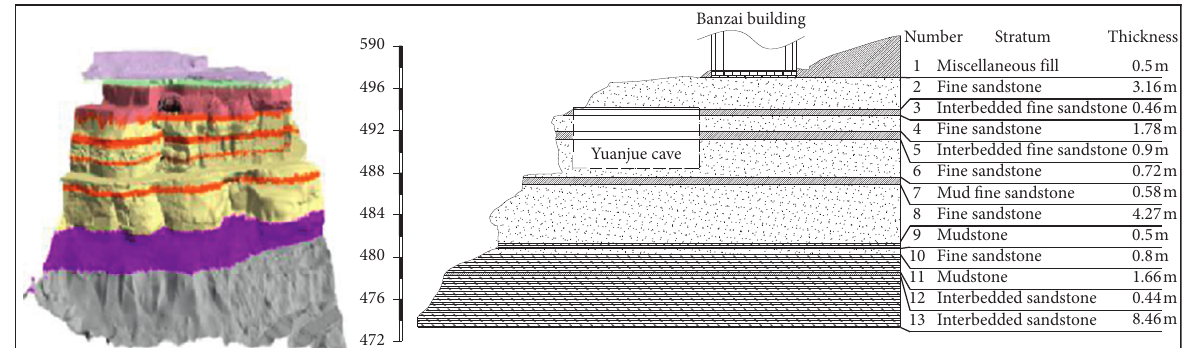
Figure 6: Lithological distribution of the south cliff of Giant Buddha